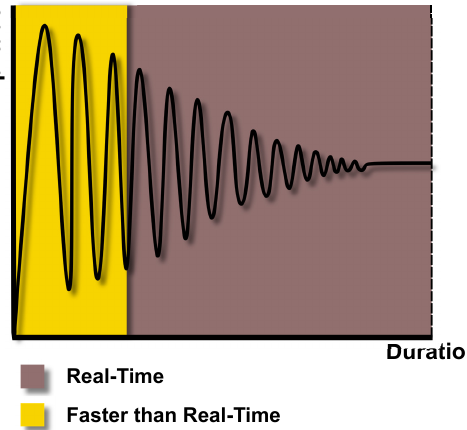
Figure 10. Real-time simulation vs. Faster than Real-Time simulation. The signal here represents the voltage oscillation due to a transient